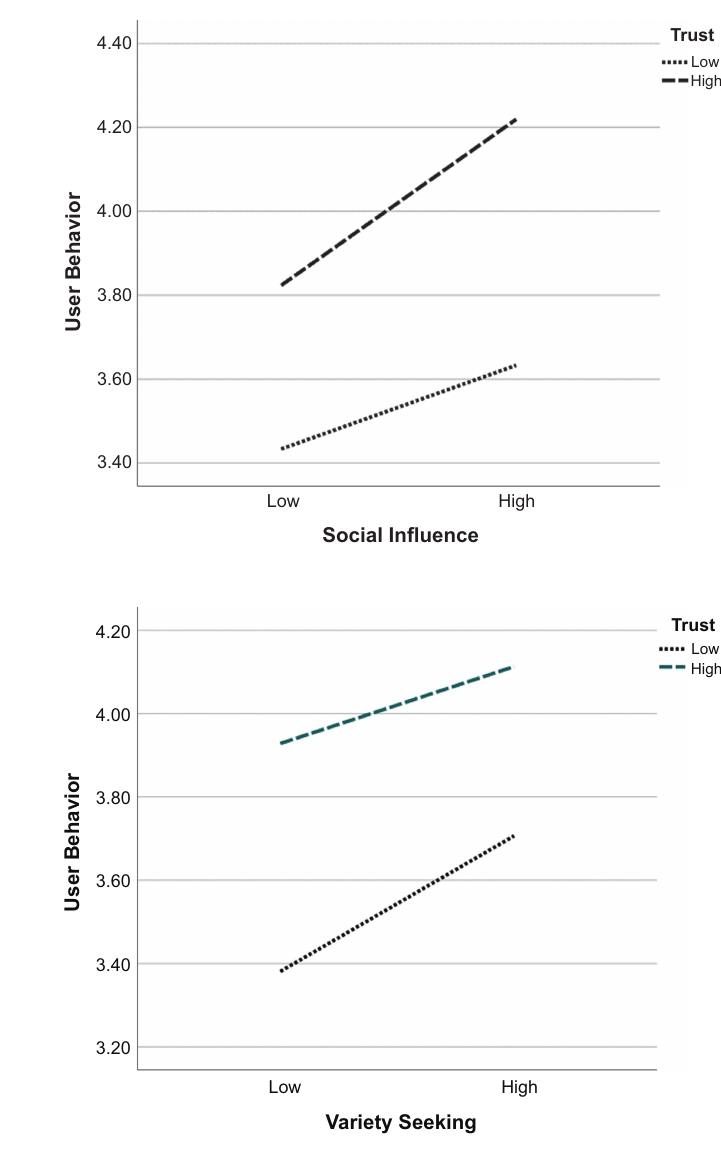
Figure 3. Trustasamoderatorin the relationship between variety seeking and user behavior